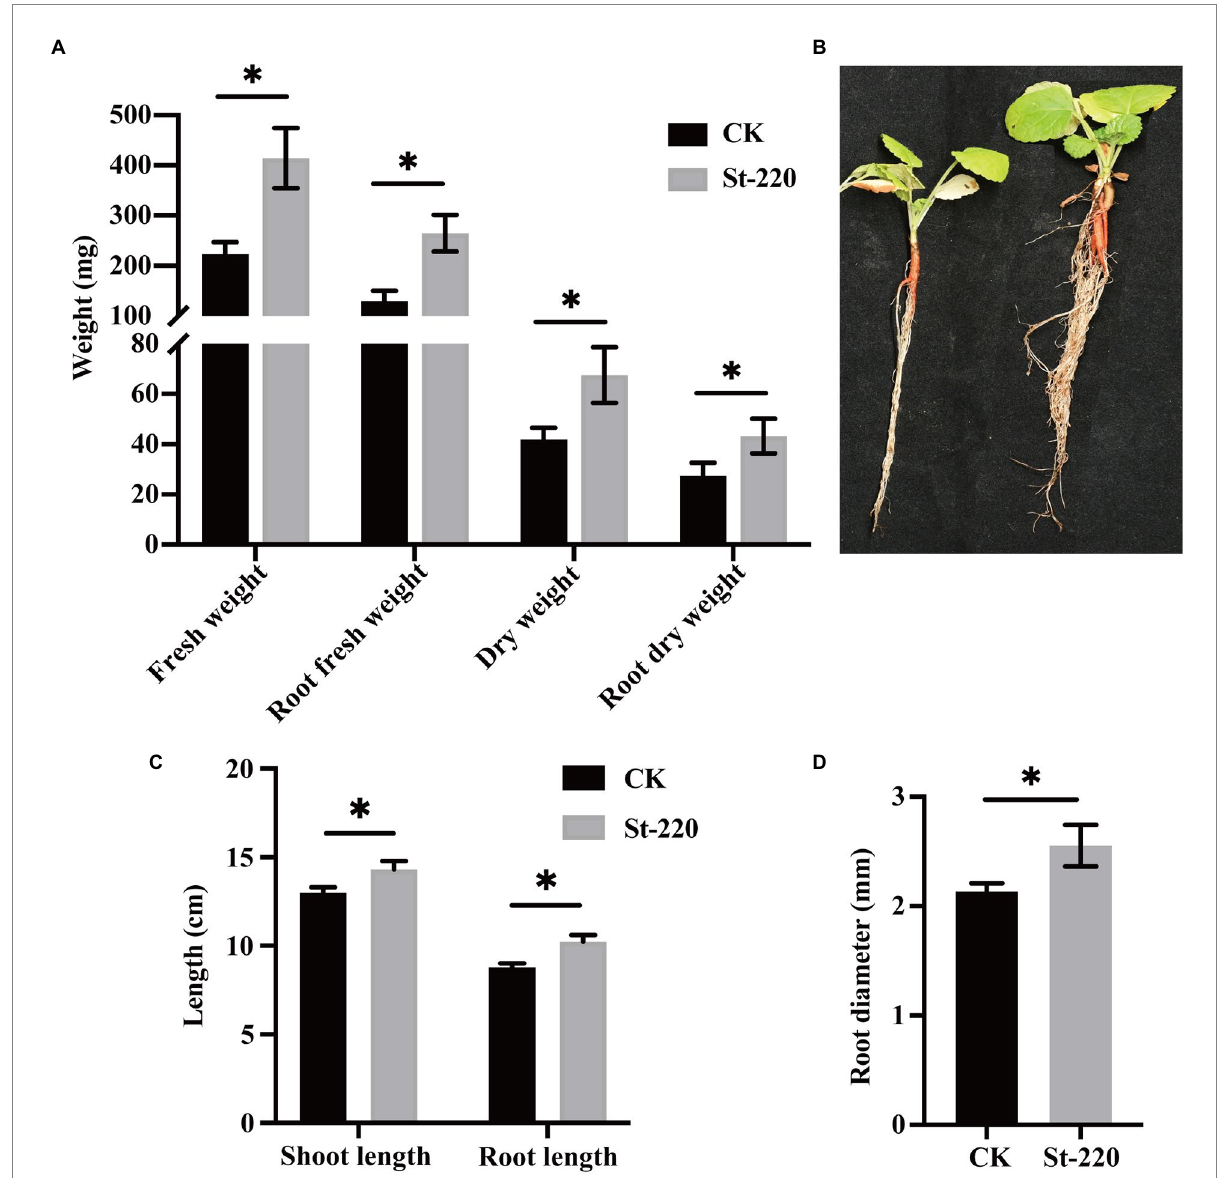
FIGURE 4 The growth-promoting effect of St-220 on Salvia miltiorrhiza seedlings. The growth-promoting activity of strains St-220 was measured under greenhouse conditions, and the data were recorded at 40 days after inoculation. (A) the biomass of Sa. miltiorrhiza seedlings. (B) overall development of Sa. miltiorrhiza seedlings inoculated with sterile water (left) and St-220 (right). The shoot height, root length (C) and root diameter (D) of Sa. miltiorrhiza seedlings inoculated with sterile water and cell suspension of St-220. Data are mean ± SE ( n = 10). Means were considered statistically different when p < 0.05, Bars with ∗ above are statistically different, ns above are not statistically